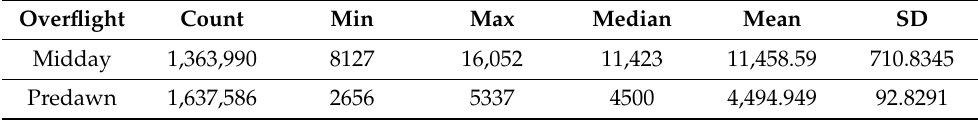
Table A3. 2011 overflight DN statistics.